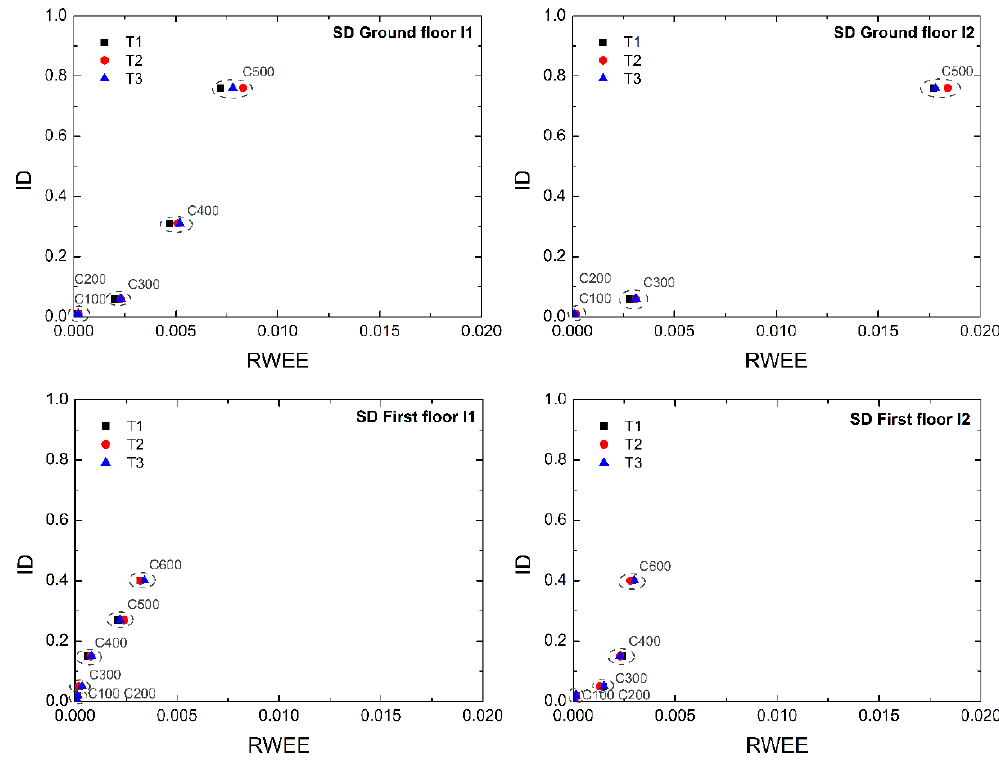
Figure 10. RWEE vs. ID for each I ‐ section of the dampers of SD.